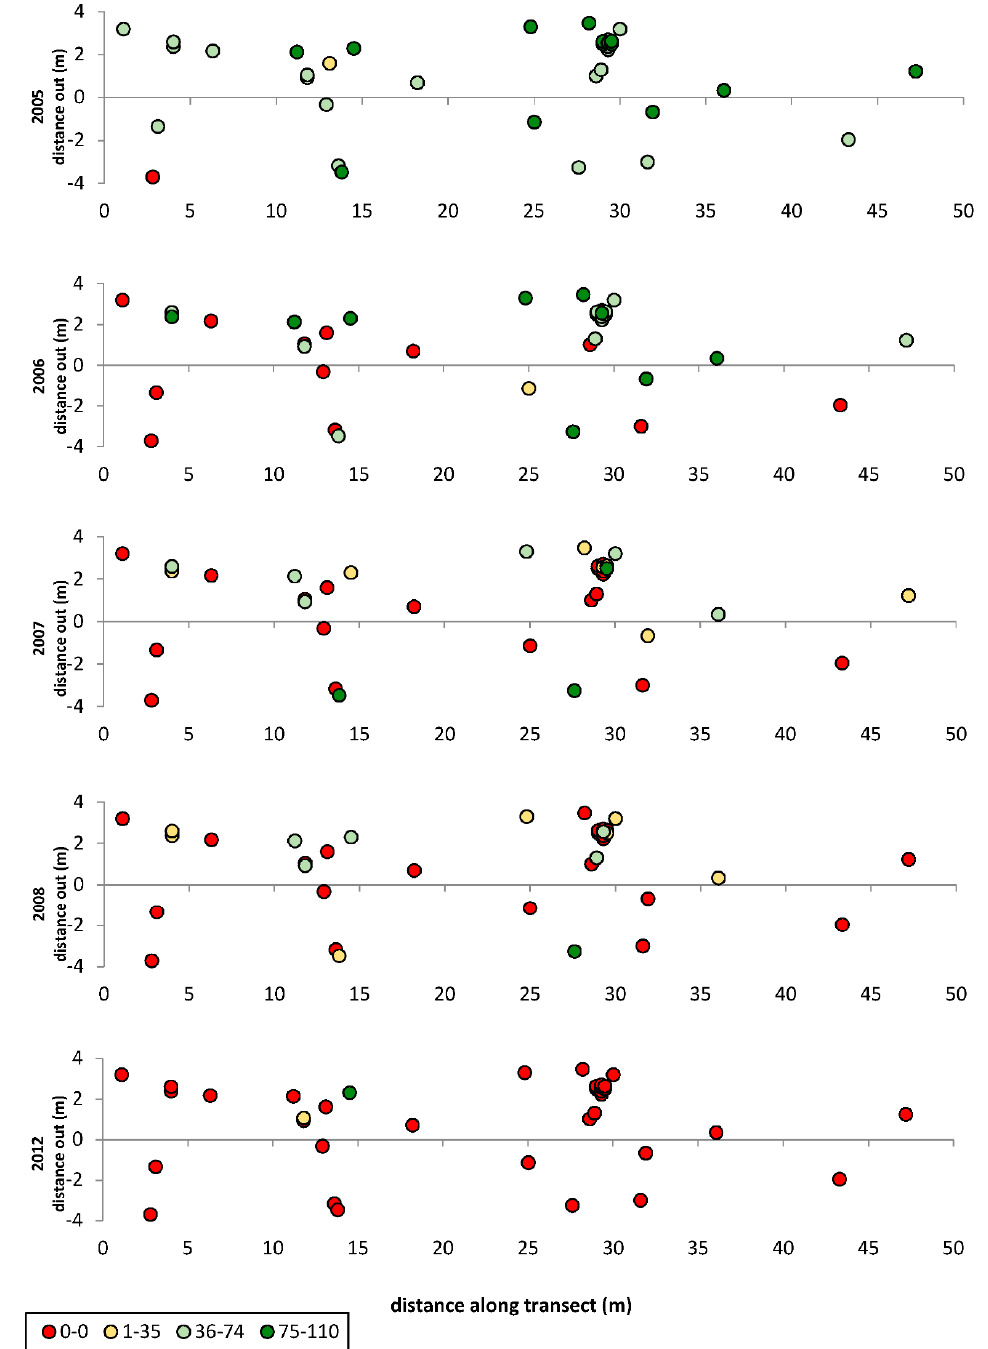
Figure 10. Transect 2, Individual seedling recruitment and health rating from June 2005 to June 2008 with a final rating in 2012. Health categories: = dead, = ratings 1–35, = ratings 36–74, = ratings 75–110.